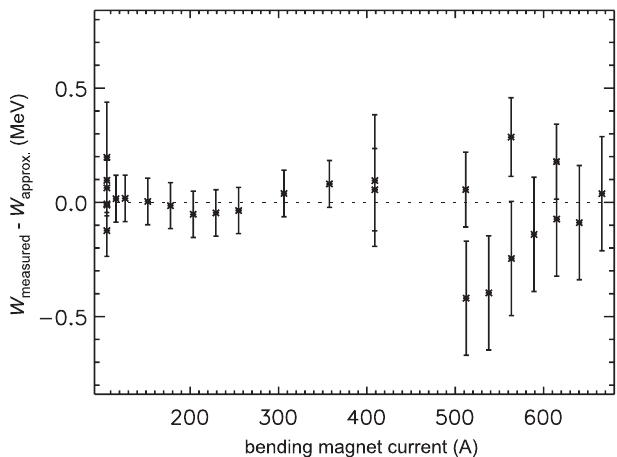
FIG. 9. Difference between measured electron energy and that calculated by the approximation for increasing bending magnet currents.